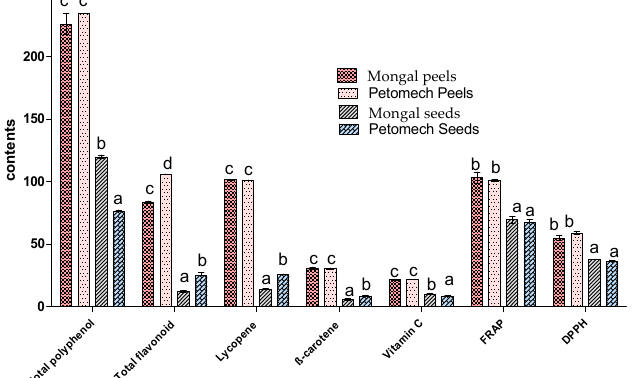
Figure 3. Ash and mineral contents of seeds and peels of F1 Mongal and Petomech.